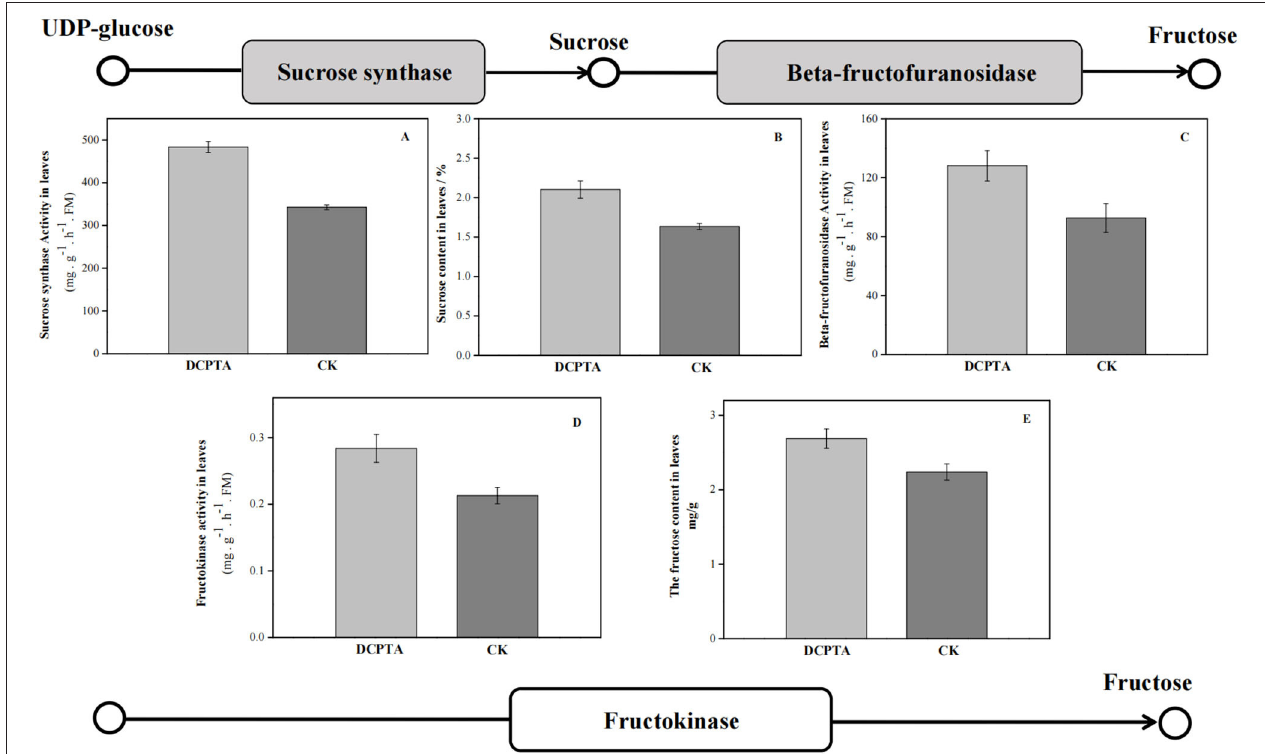
FIGURE 6 | KEGG-enrichment analyses of DEGs. (A) Sucrose synthase activity; (B) Sucrose content; (C) Beta-fructofuranosidase activity; (D) Fructokinase activity; and (E) Fructose content at 7 days after